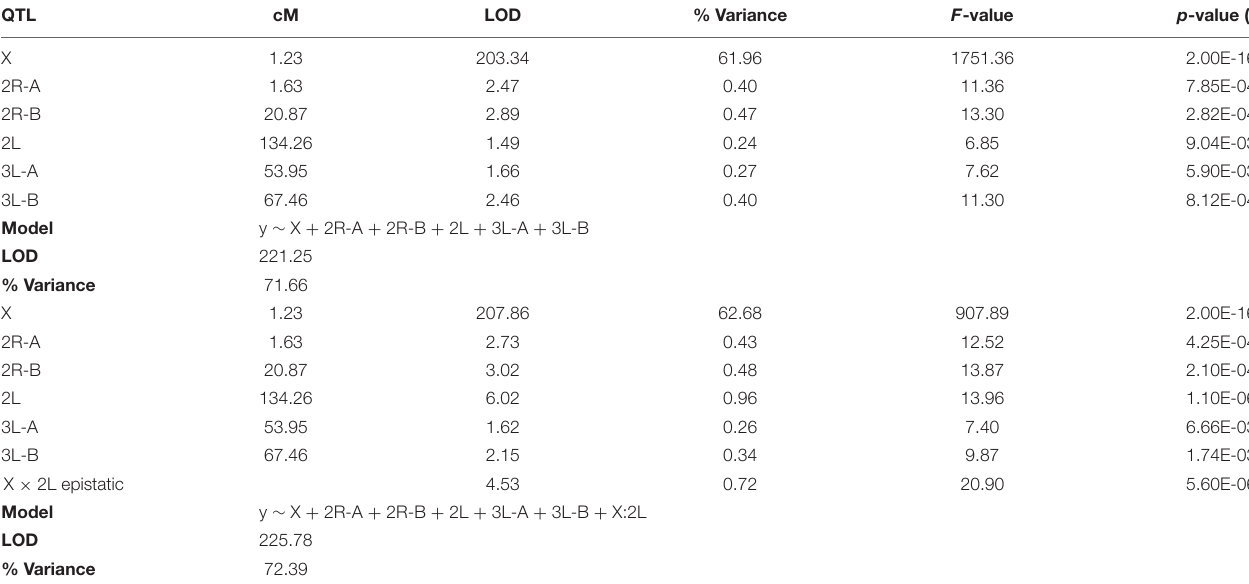
TABLE 4 | Results of two multiple imputation QTL models